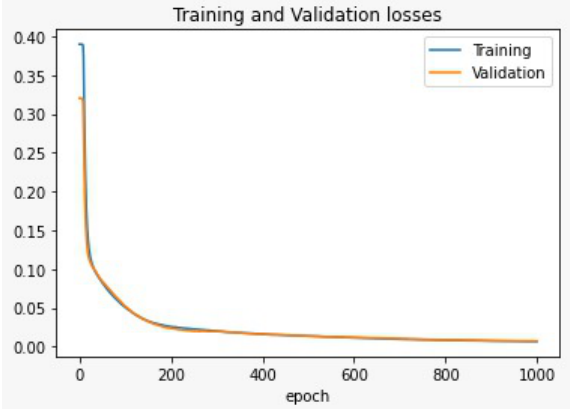
Figure 9. The training and validation losses or the double hidden layers deep learning